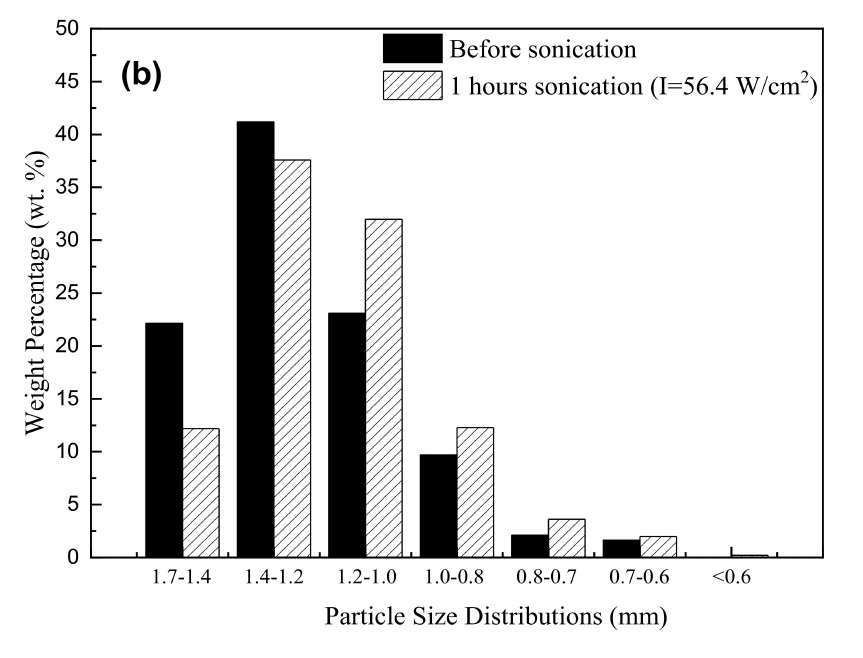
Figure 6. Particle size distributions of activated carbon before and after sonication at 24.5 W / cm 2 ( a ) and 56.4 W / cm 2 ( b ) for 1.0 h.